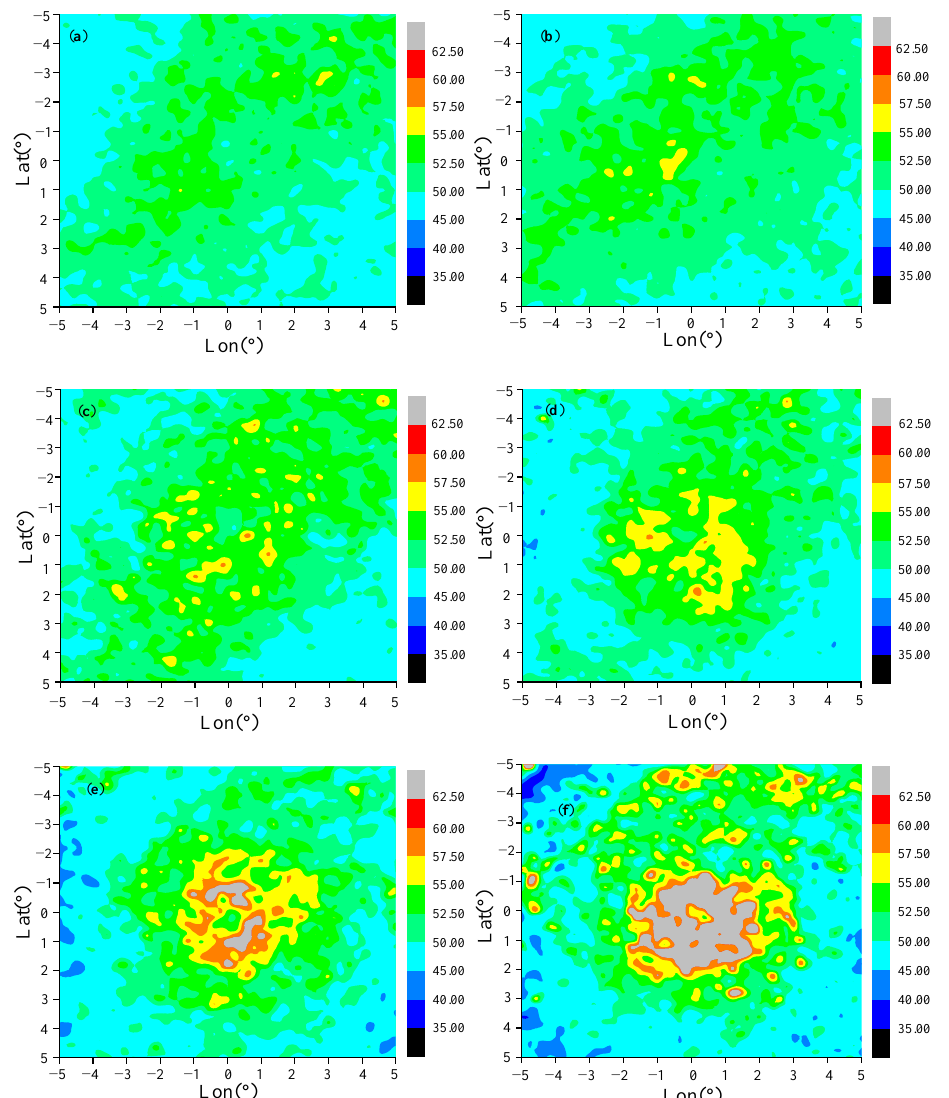
Figure 10. Spatial distribution of cirrus effective diameter (μm) by TC intensity: ( a ) TD, ( b ) TS, ( c ) STS, ( d ) TY, ( e ) STY, and ( f ) Super TY.